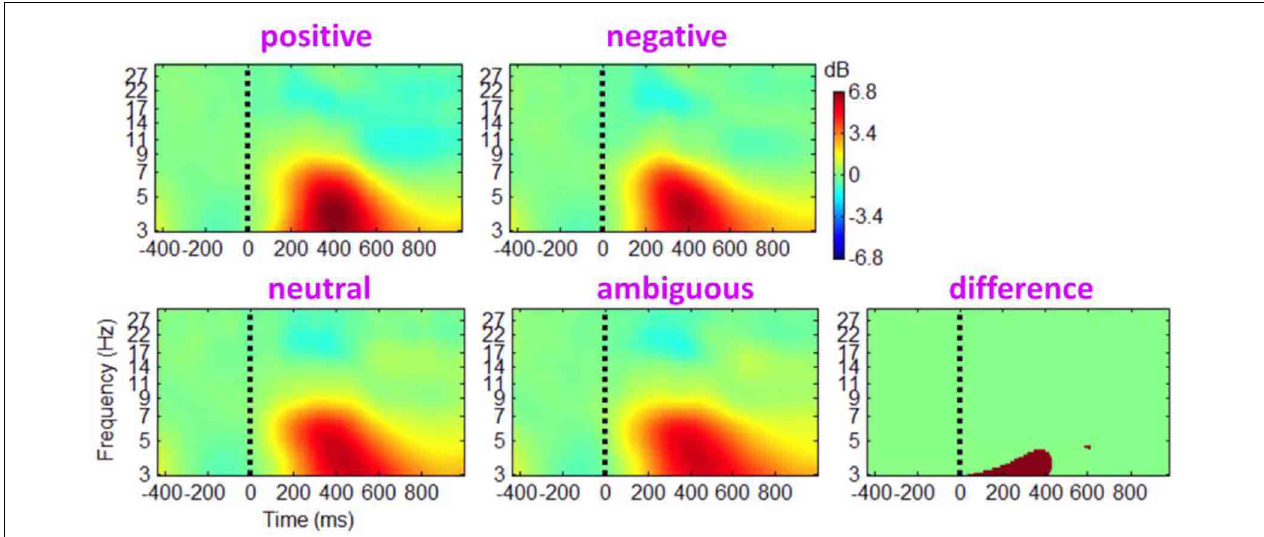
FIGURE A1 | Grand-mean ERSPs of the main effect of outcome valence based on channel EEG data. Results obtained from the electrode site